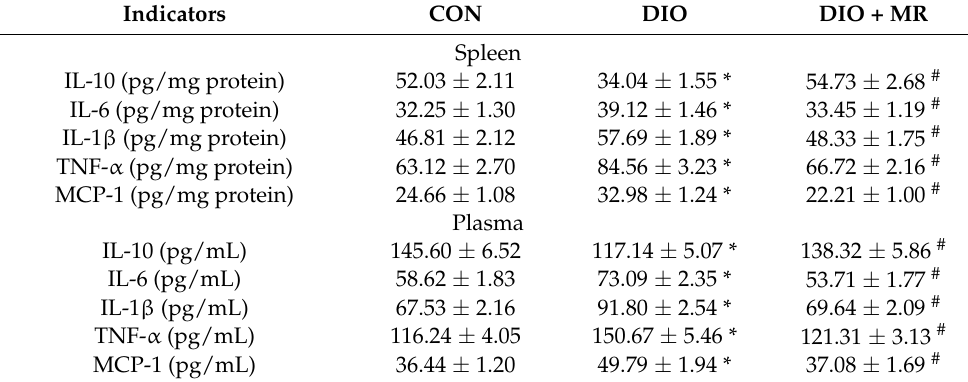
Table 2. Effects of MR on the levels of inflammatory cytokines in spleen and plasma in obese mice.